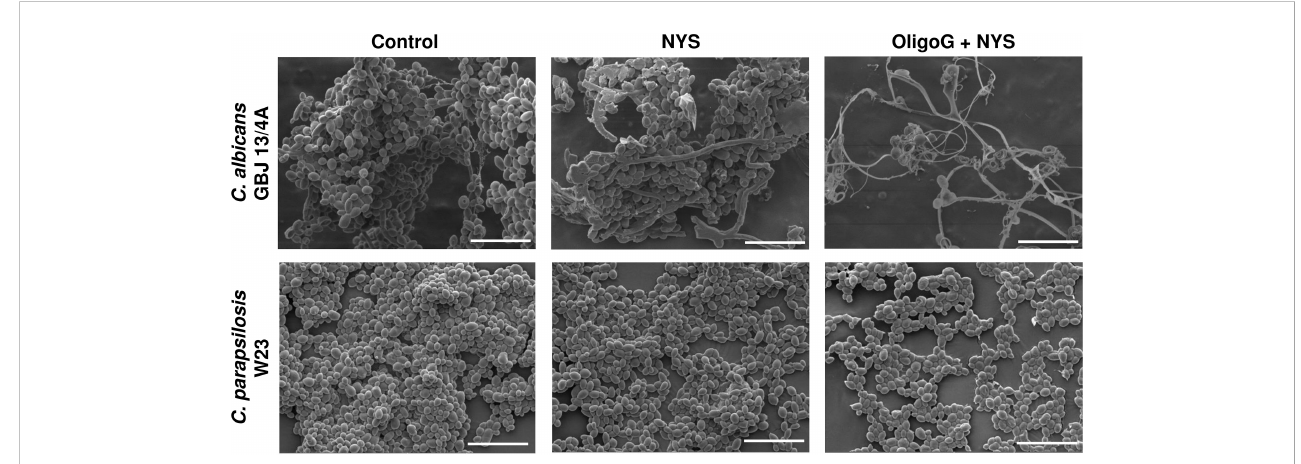
FIGURE 3 SEM imaging of C. albicans GBJ 13/4A and C. parapsilosis W23 bio fi lm formation on silicone surfaces treated with 4% OligoG in combination with 1 µg/ ml nystatin (NYS) after 24 h growth (n=3); scale bar = 20 m m.